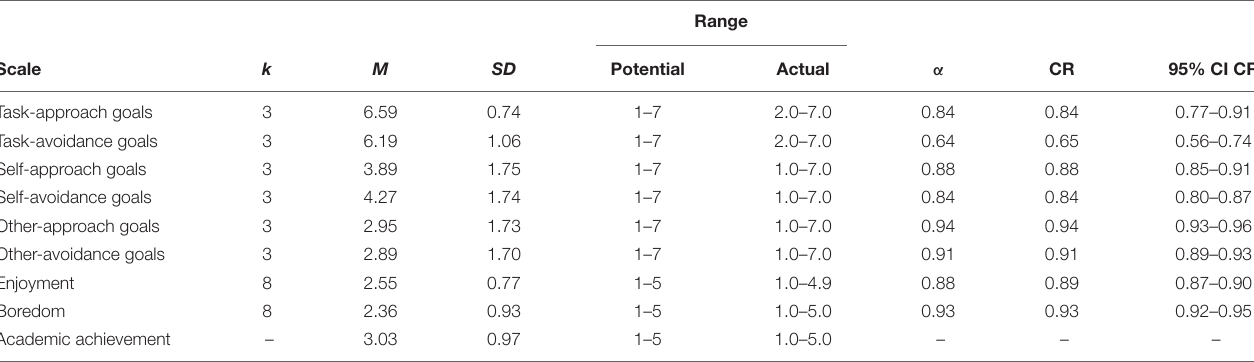
TABLE 1 | Psychometric properties of achievement goals, emotions and performance.